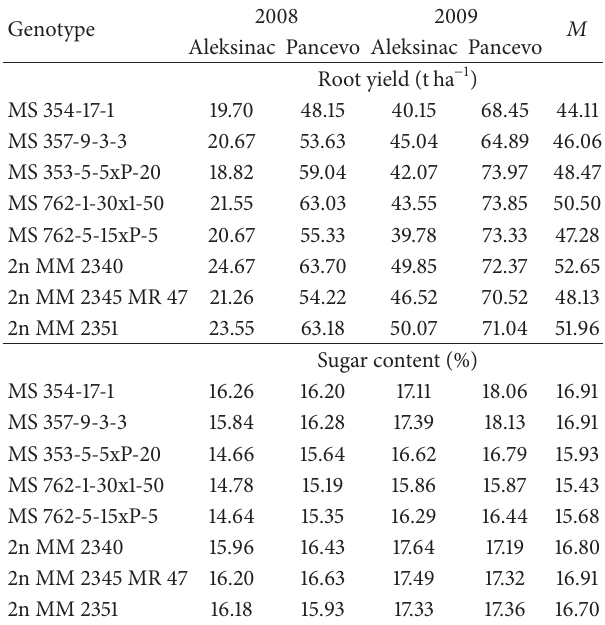
Table 1: Mean values of root yield and sugar content of the parental